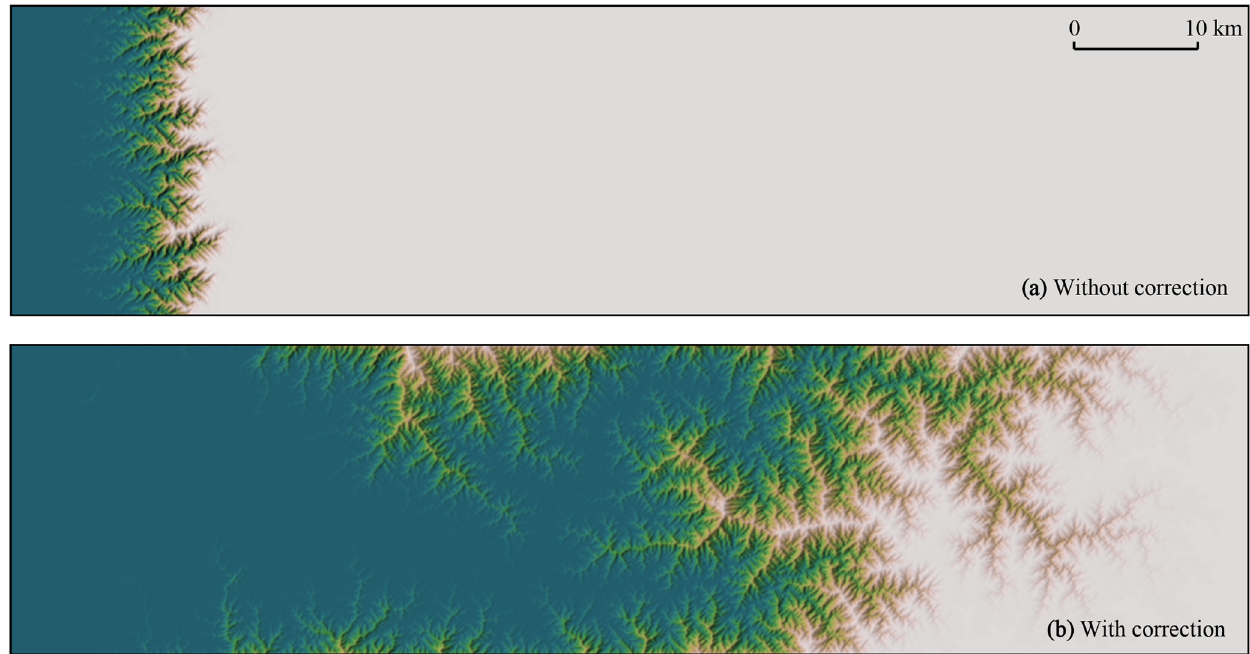
Figure 1. Simulation of the evolution of an escarpment over 70 time steps of 1000 years each and on a 1024 × 256 regular grid, using the FastScape model (Braun and Willett, 2013, see also Sect. 3 below). The grid nodes of the leftmost column (boundary nodes) have a fixed elevation while the initial elevation of the other nodes corresponds to a 500 m high flat surface with small random perturbations. Using the same set of model parameters, simulation results are shown (a) without and (b) with correction of flow routing in local depressions at each time step. As illustrated, flow path disruptions in (a) cause a much slower migration of the escarpment, while the topography predicted in (b) is usually considered more realistic, especially under temperate or humid